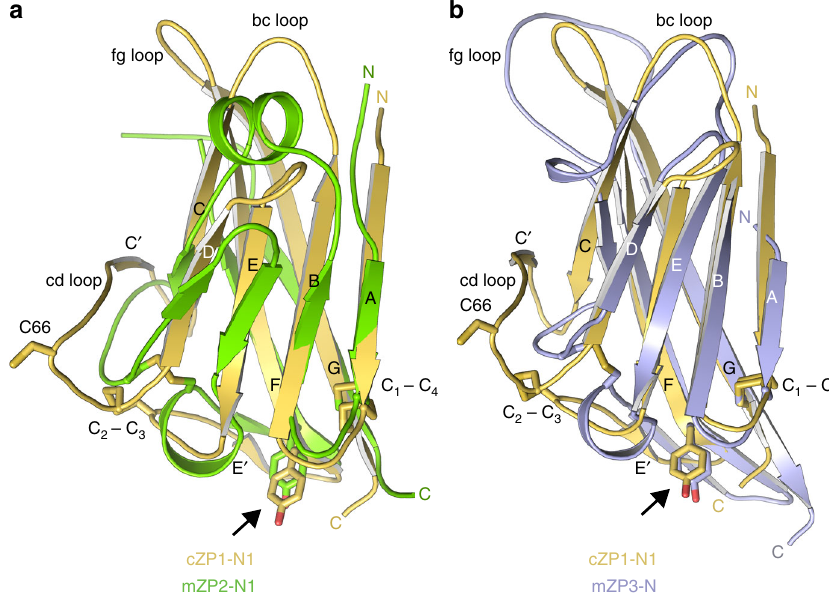
Fig. 4 Structural comparison of ZP-N domains from vertebrate ZP1, ZP2 and ZP3. a Superimposition of cZP1-N1 (chain B of the highest resolution structure, PDB 6GF6) and mZP2-N1 (PDB 5II6), with a root-mean-square deviation (RMSD) of 2.1 Å over 74 aligned residues (13% sequence identity). Cross-linking C66, conserved intramolecular disulphides and β -strand F Tyr (arrow) are shown as sticks. b Superimposition of cZP1-N1 and mZP3-N (chain A of PDB 5OSQ), with a RMSD of 2.1 Å over 75 aligned residues (11% sequence identity). Note how the bc and fg loops of cZP1-N1 are signi fi cantly shorter than those of a cross-linking function. However, SEC analysis of puri fi ed hZP4- N1 (Fig. 9a) as well as pull-down experiments of Myc-tagged hZP4-N1 using an equivalent histidine-tagged construct (Fig. 9b) indicate that the protein is entirely monomeric. On the other hand, parallel experiments using cZP4-N1 indicate that, in the chicken, ZP4 forms a non-covalent homodimer (Fig. 9a – c).